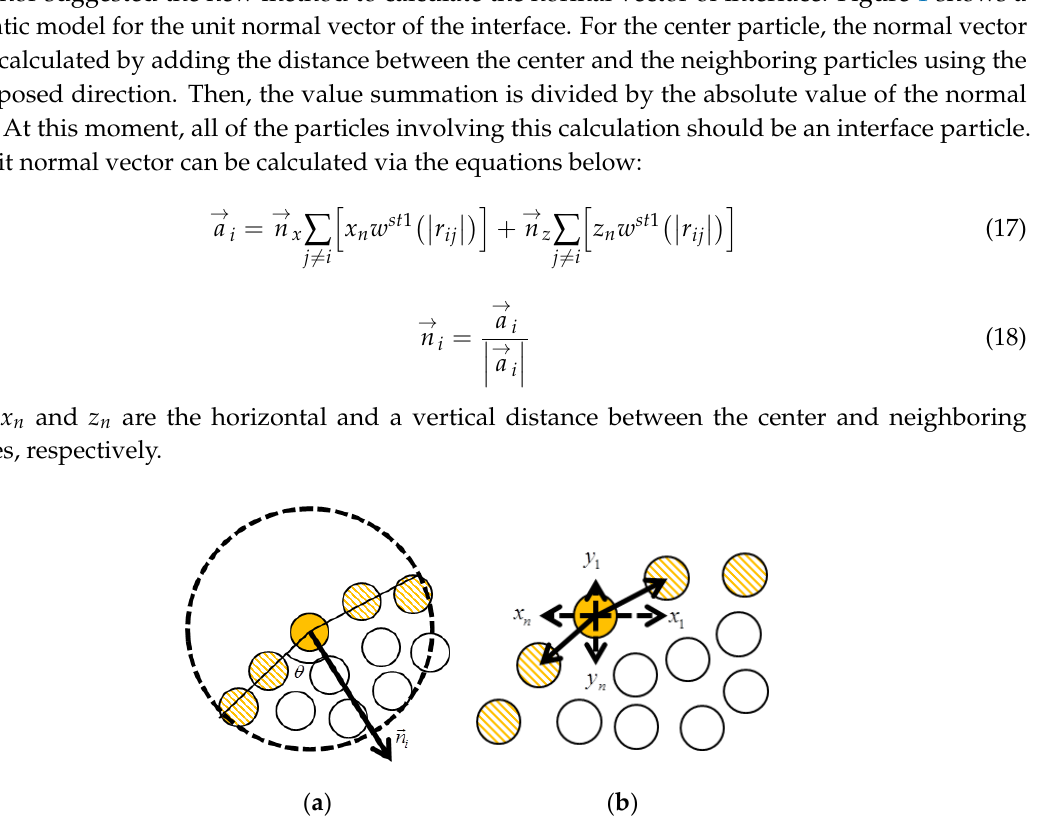
Figure 1. ( a ) Schematic of a curvature of interface and ( b ) finding method for a normal vector of interface.